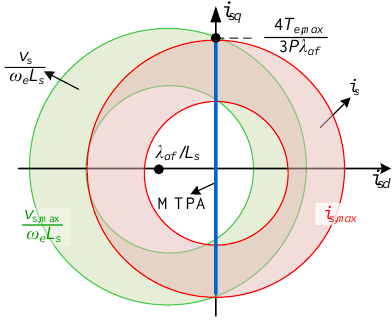
Figure 3. PMSM drive constraints.